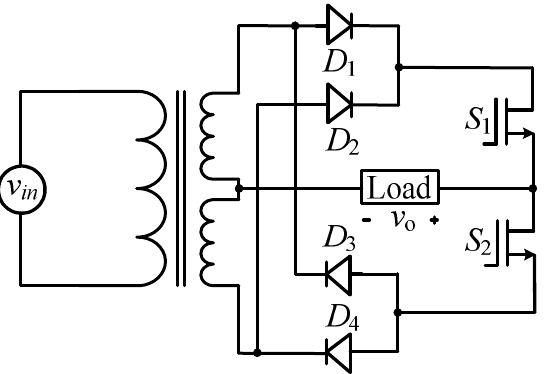
Figure 3. Direct frequency converter topology based on center tap transformer. The use of large component count and solid-state devices is reduced in the proposed research. Here variable frequency at the output is ensured by cascading a